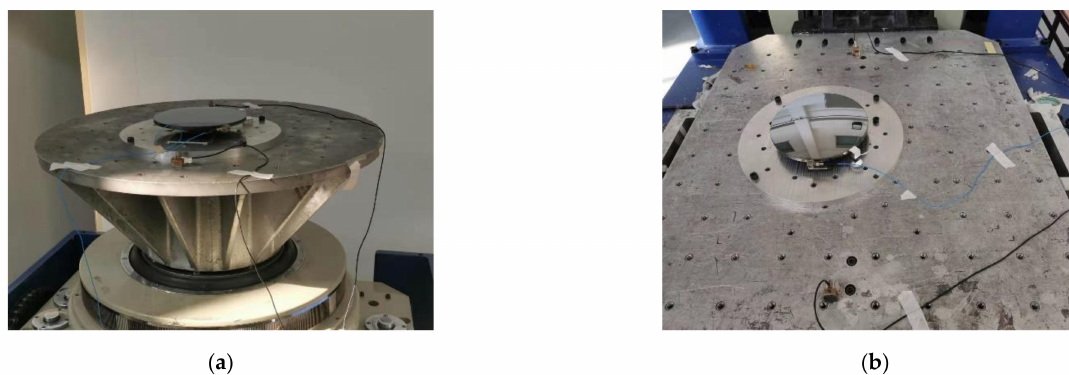
Figure 14. The test of mechanical vibration: ( a ) Z-direction vibration (axial) ( b ) Y-direction vibration (lateral).